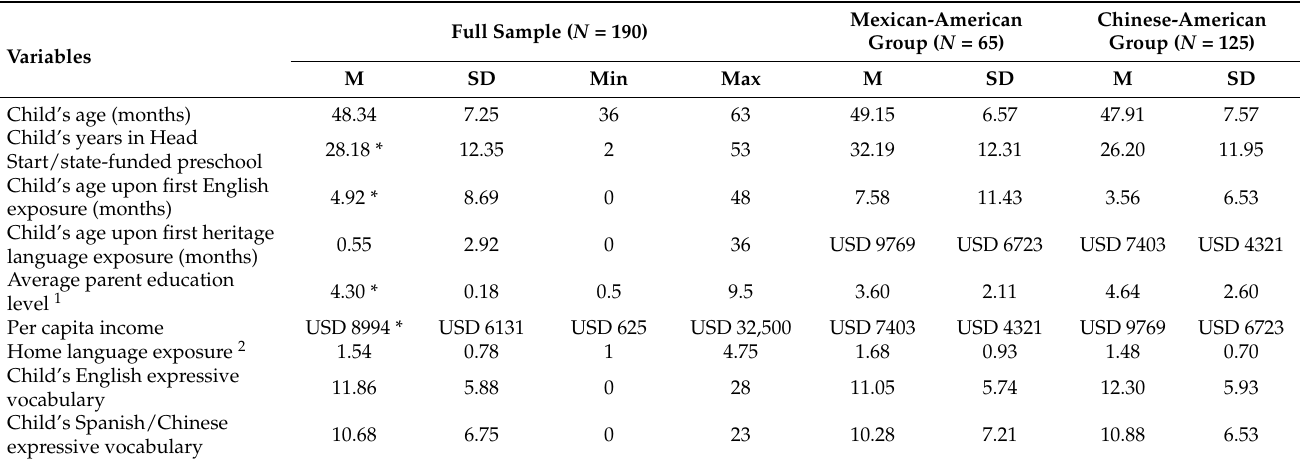
Table 4. Descriptive statistics of child and family variables for the full sample and by cultural groups ( N =